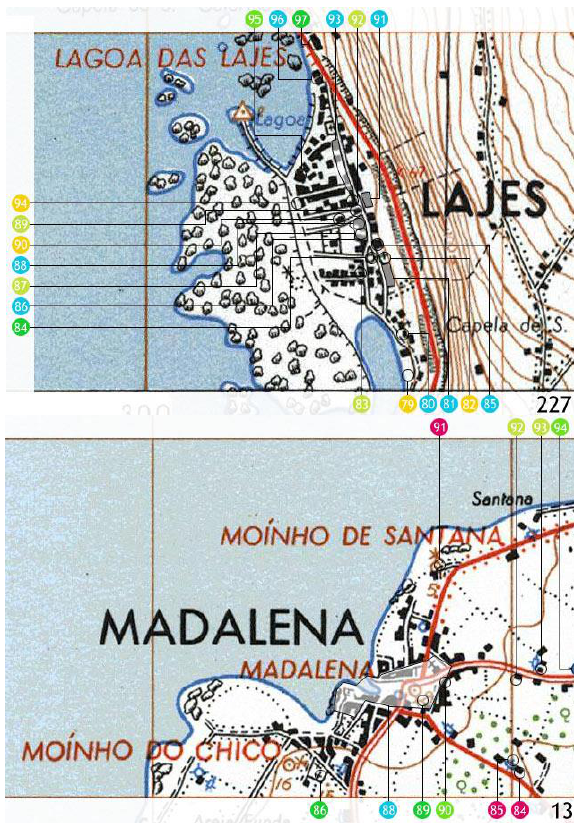
Figure 2. Cartography of Lajes and Madalena villages around 1980. Source: Inventário do Património Imóvel dos Açores. Figure 2 presents the settlements of Lajes and Madalena, around 1980. The villages were born from the best sites with natural conditions to build a port, for economic sea activities and transport.